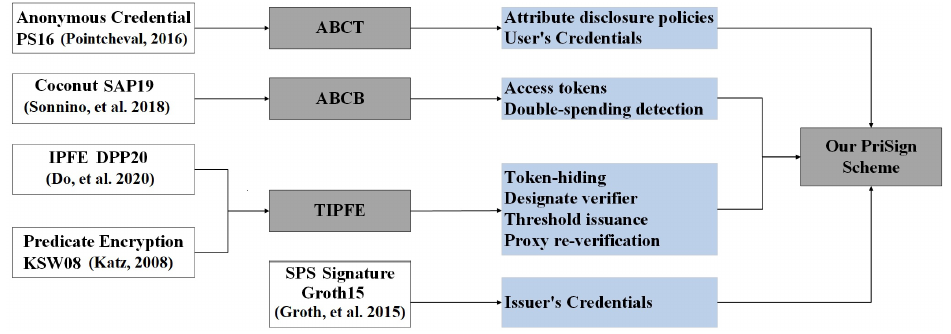
Figure 7. Building blocks and roadmap